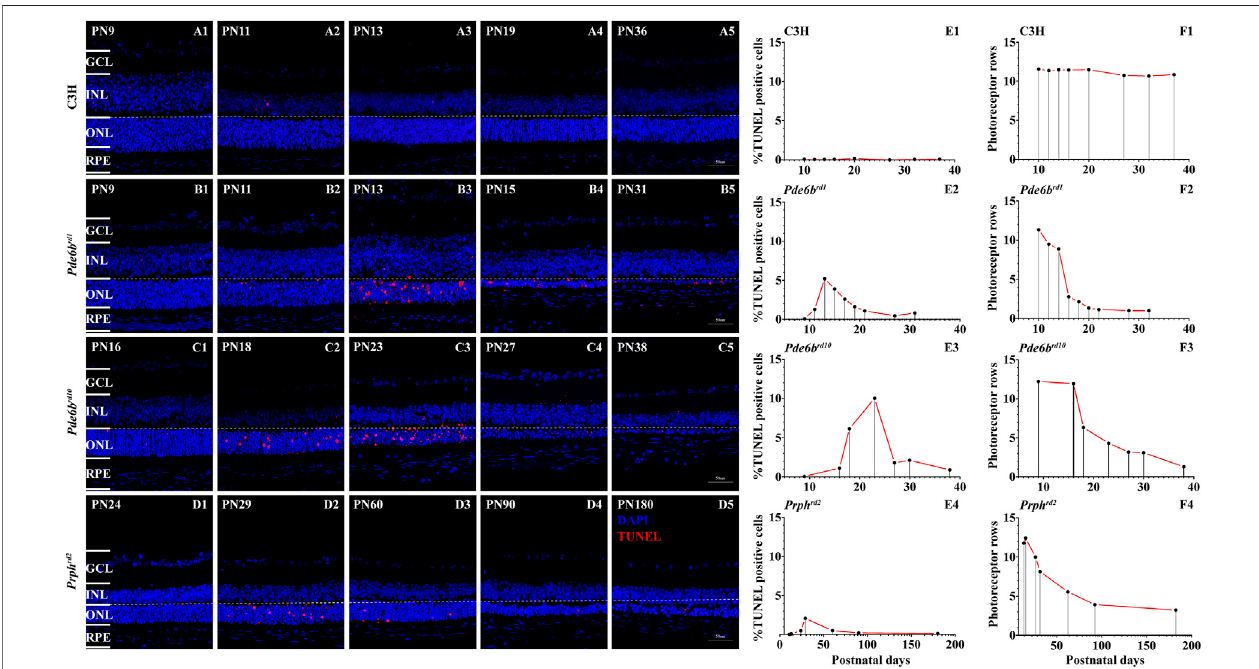
FIGURE 1 | TUNEL assay and cell death in RD mutants. The number of TUNEL positive cells in the three different RD mutants ONL was strongly increased when comparedwithwt (A1 – D5) .Quanti fi cationofphotoreceptor celldeathandphotoreceptorrowsduring the fi rst 40postnatal days inC3Hwild-type, Pde6b rd1 , Pde6b rd10 mutants and 180 days in Prph rd2 (A – F) . Increased numbers of TUNEL positive cells, showing a peak at PN13 in Pde6b rd1 , PN23 in Pde6b rd10 , PN29 in Prph rd2 was observed (B1 – D5) . Quanti fi cation of photoreceptor rows during the fi rst 40 postnatal days in Pde6b rd1 , Pde6b rd10 , C3H and 180 days in Prph rd2 . In Pde6b rd1 , photoreceptorrowsshowedthehighestnumberatPN9(13ONLcellrowsremaining),decliningthereafter.Intheothertwomutantsthephotoreceptorrowsshowedthe highest number at PN9 in Pde6b rd10 (12 ONL cell rows remaining) and PN13 in Prph rd2 , declining thereafter. In the RD models, dying cells and photoreceptor cells rows were detectable as late at PN40 in Pde6b rd1 and Pde6b rd10 (B5, C5) , at PN180 in Prph rd2 (D5) . The values shown originate from three RD mutants from at least three different specimens. Scale bar represents 50